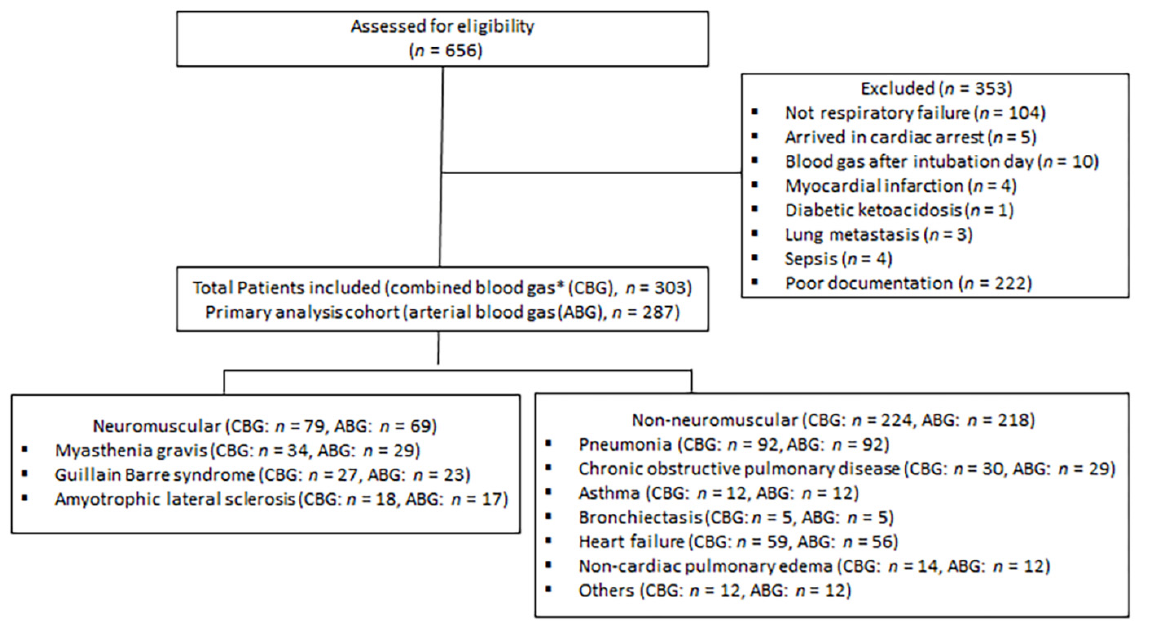
Figure 1. Flow chart as per STROBE (STrengthening the Reporting of OBservational studies in Epidemiology) guidelines. * Combined blood gas includes venous blood gas if the patient did not have arterial blood gas on initial presentation.